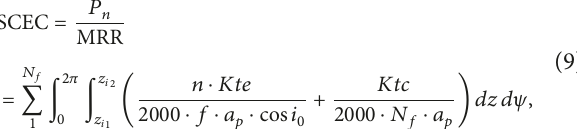
Figure 3: Diagram for executing the hybrid incremental model.